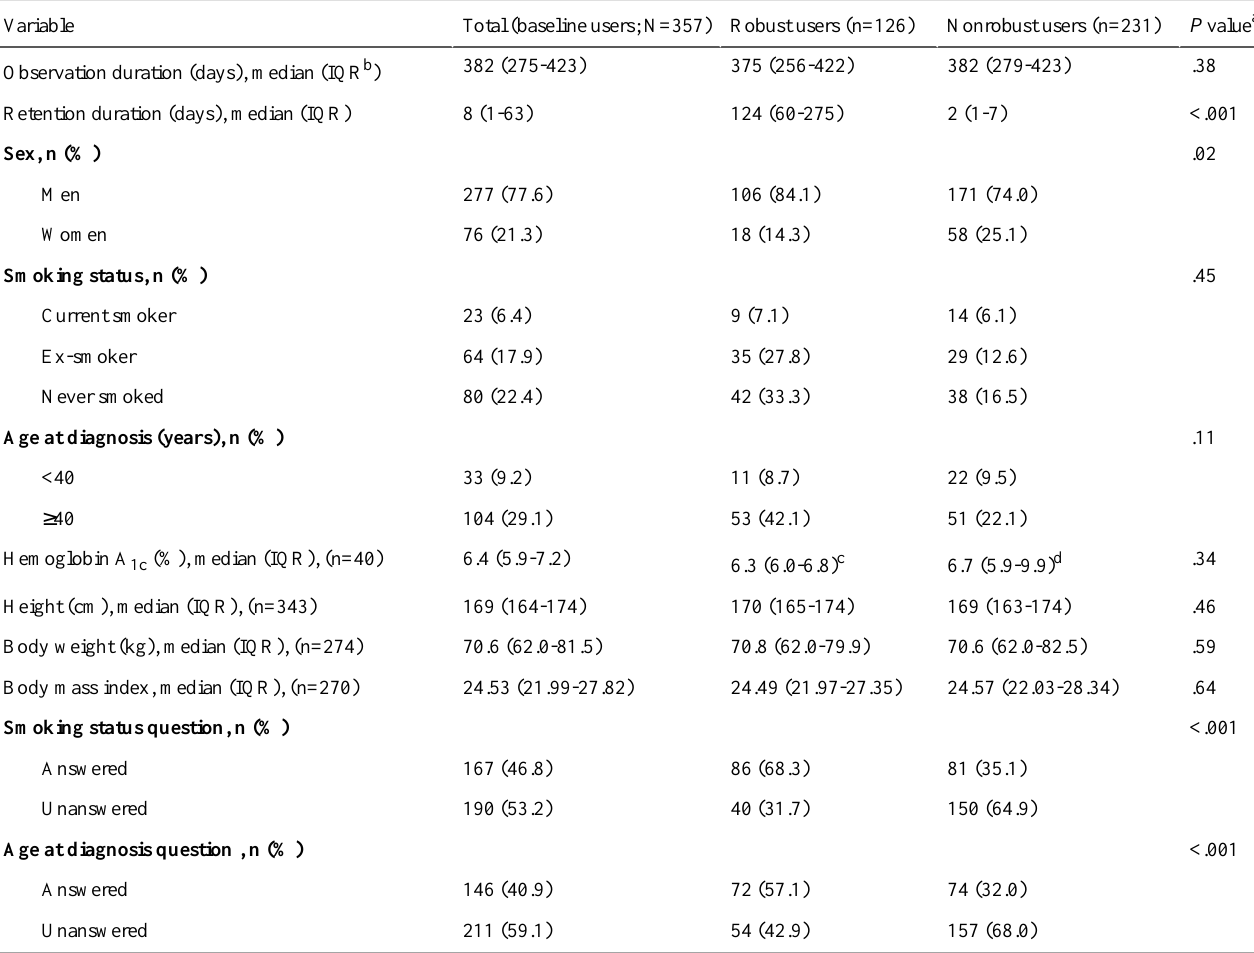
Table 3. Comparison of demographics of robust versus nonrobust